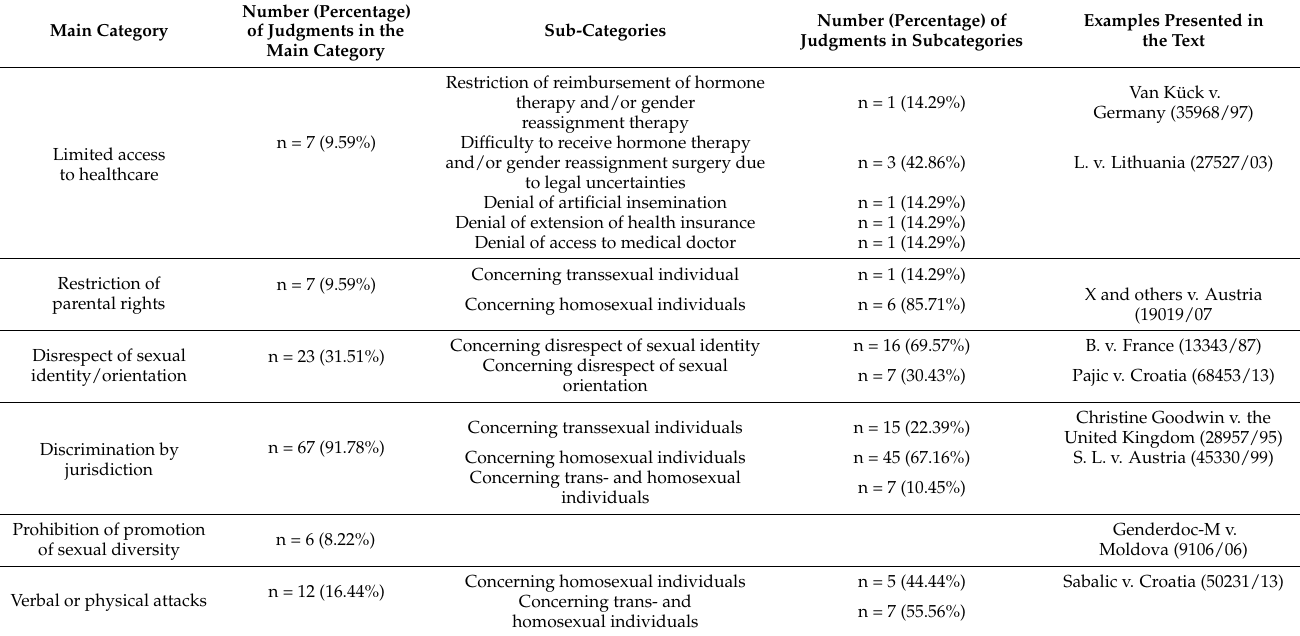
Table 3. Overview of the categories and sub-categories identified and the assigned